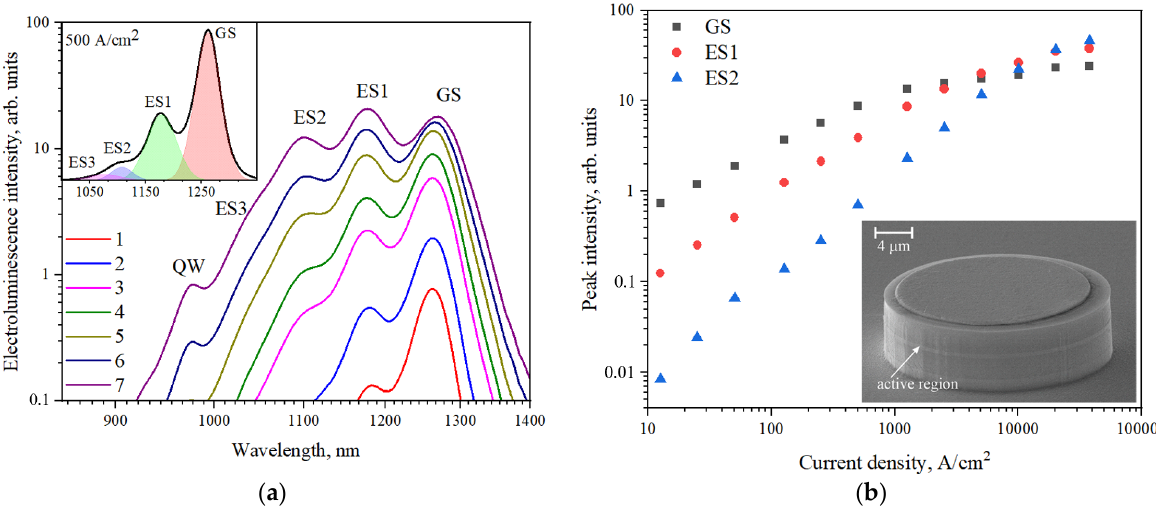
Figure 1. Spontaneous electroluminescence spectra ( a ) of the heterostructure with InAs/InGaAs quantum dots, measured at the room temperature at different injection currents (1: 15 A/cm 2 ; 2: 50 A/cm 2 ; 3: 250 A/cm 2 ; 4: 500 A/cm 2 ; 5: 1250 A/cm 2 ; 6: 2500 A/cm 2 ; 7: 5000 A/cm 2 ). The inset shows the decomposition of the electroluminescence spectrum (4) with the Gauss contours; ( b ) peak intensities of three optical transitions against current density. Inset: microscopic image of the 24 μ m microdisk.